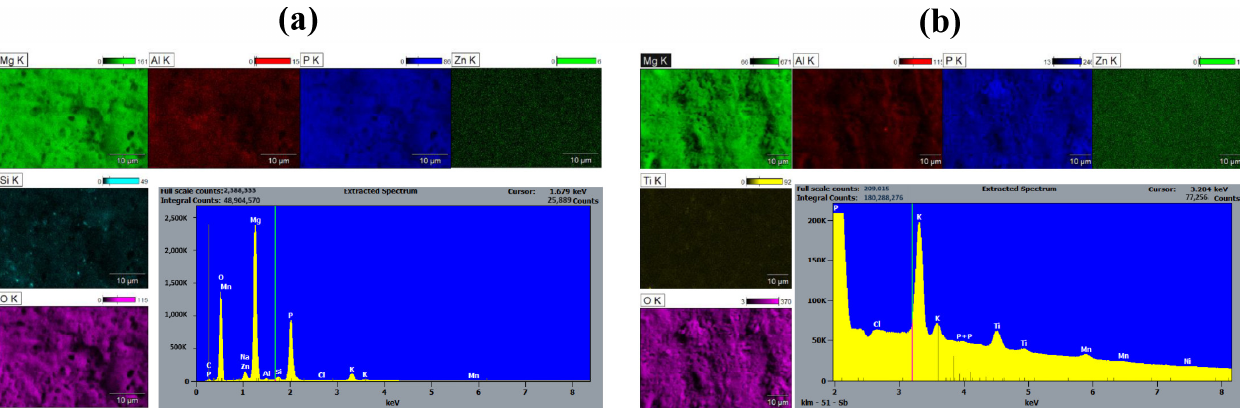
Figure 3. EDS elemental maps and spectra of the surface of ( a ) PEO@SiC-5 and ( b )